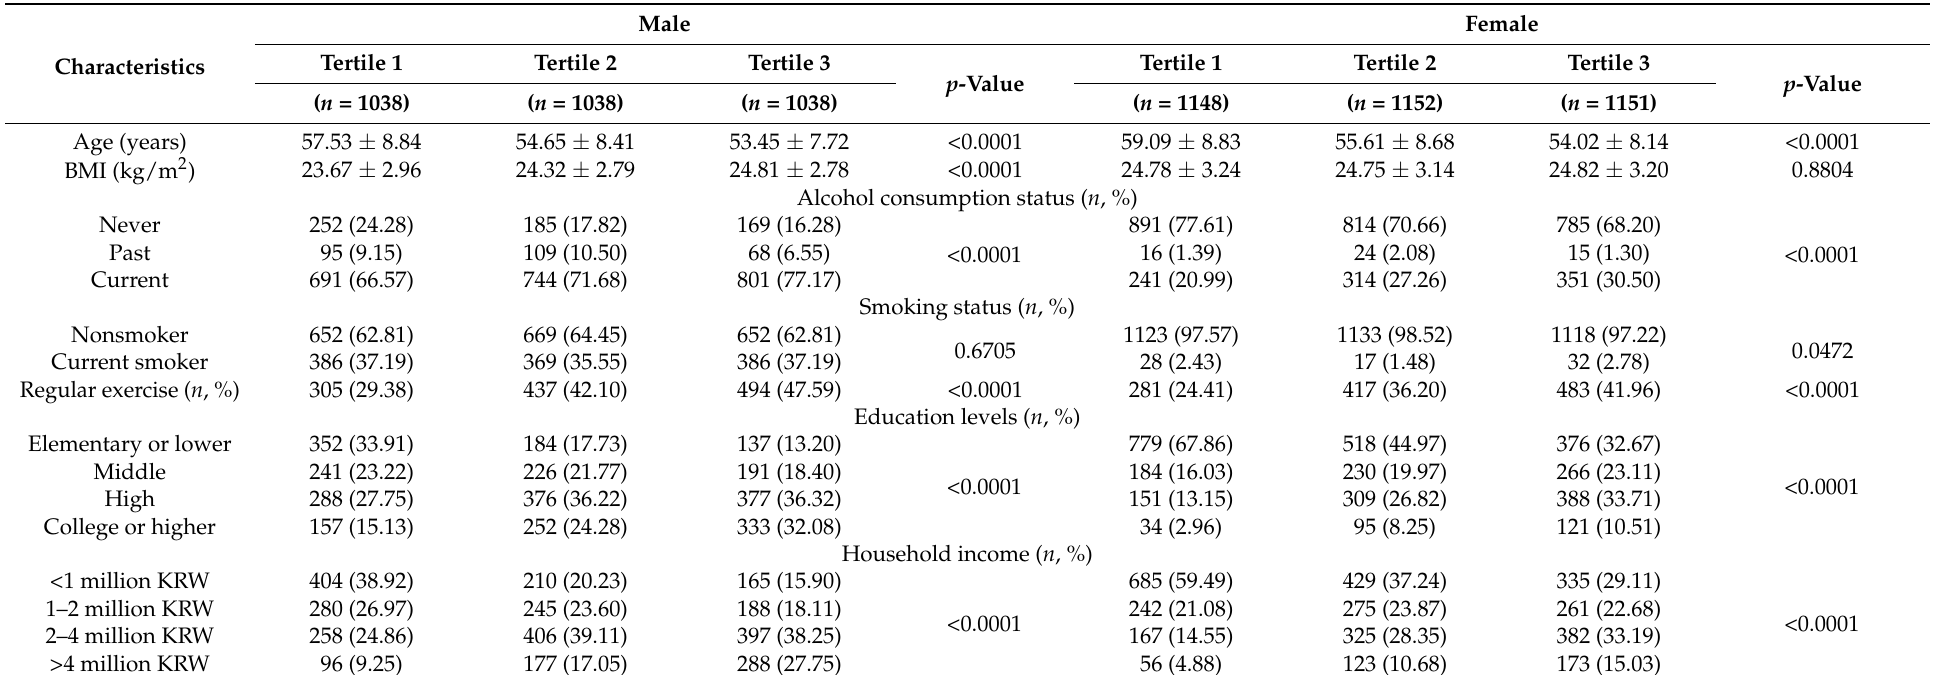
Table 1. General characteristics of male and female participants according to seafood-intake